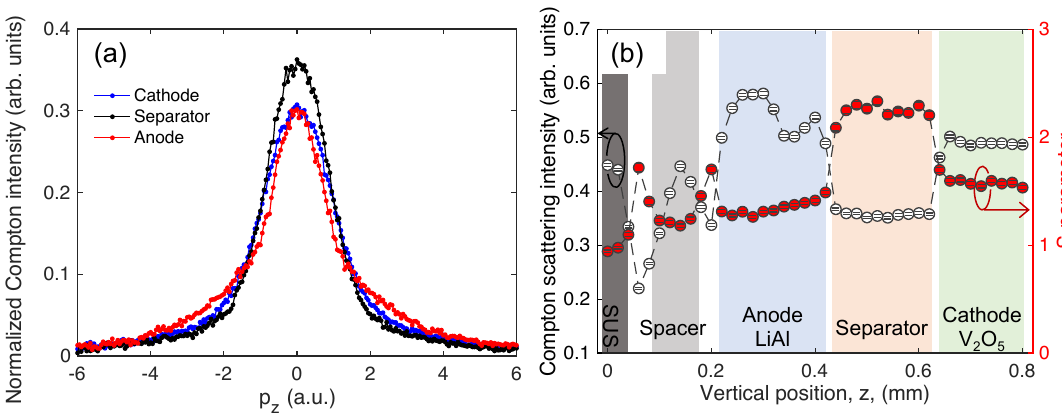
Figure 2. ( a ) Compton scattering X-ray energy spectrum obtained from the cathode (blue line), separator (black line), and anode (red line) of the fresh VL2020 cell. ( b ) The internal structure of the cell obtained from the Compton scattering intensity (white filled circle) and S-parameter (red filled circle). The background colors correspond to the regions of each component of the